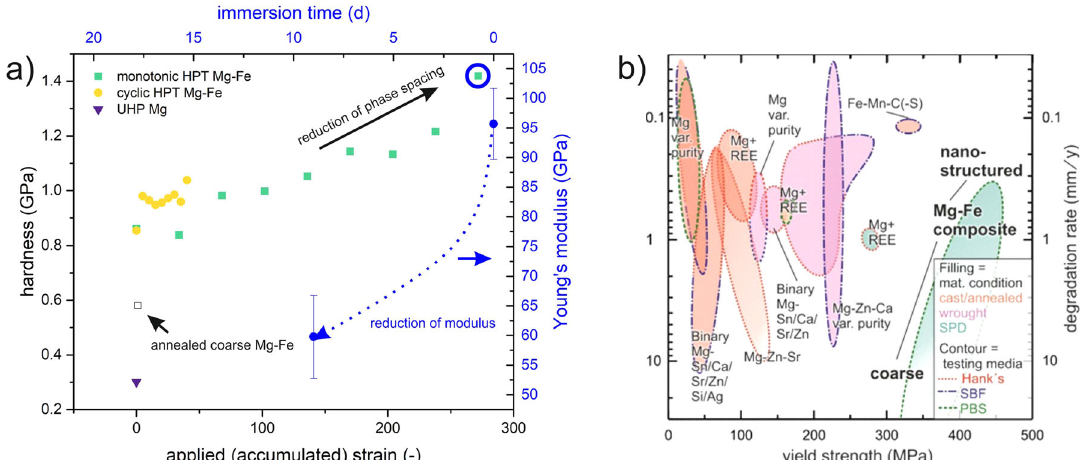
Fig. 4 Mechanical and degradation performance of Mg – Fe composites. a Hardness of the two composite types as a function of the applied (accumulated) strain. Data points of the monotonically deformed Mg – Fe composite for strains larger than ~140 correspond to the nanostructured spacing in Fig. 2. Data of UHP Mg and an annealed coarse composite are shown for comparison. The Young ’ s modulus of the nanostructured composite (best-performing condition, circled in blue) is given in its pristine state and after 9 days immersion in PBS. b Yield strength and degradation rate of various biodegradable alloys prepared by conventional methods and severe plastic deformation (cyclic extrusion and compression) compared to the new Mg – Fe composites 3,14,70 – 72 . Note that for this comparison, yield strength includes data measured in tension, compression as well as from a conversion of hardness. Slight deviations for the same test method may thus occur. Please note the inverted scaling in second (upper) x -axis in ( a ) and second (right) y- axis in ( b